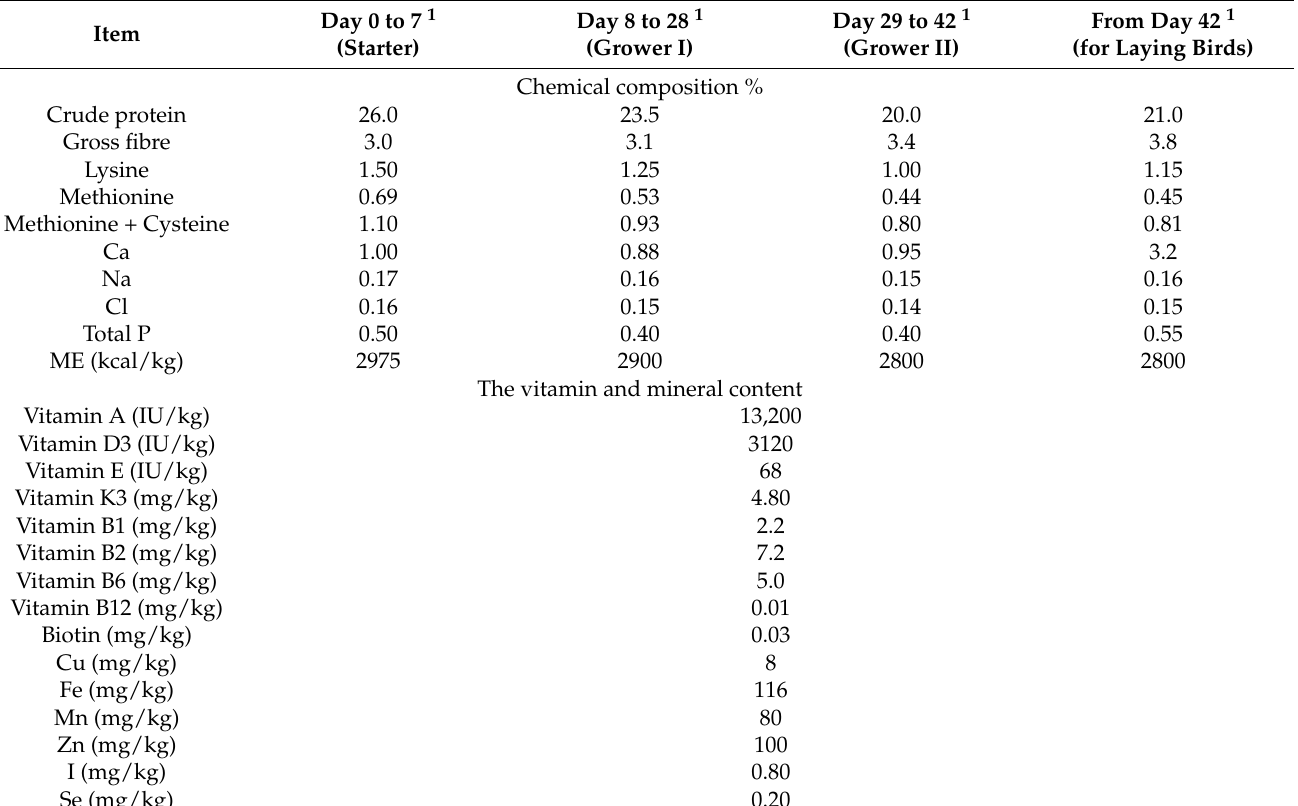
Table 6. Chemical composition of the